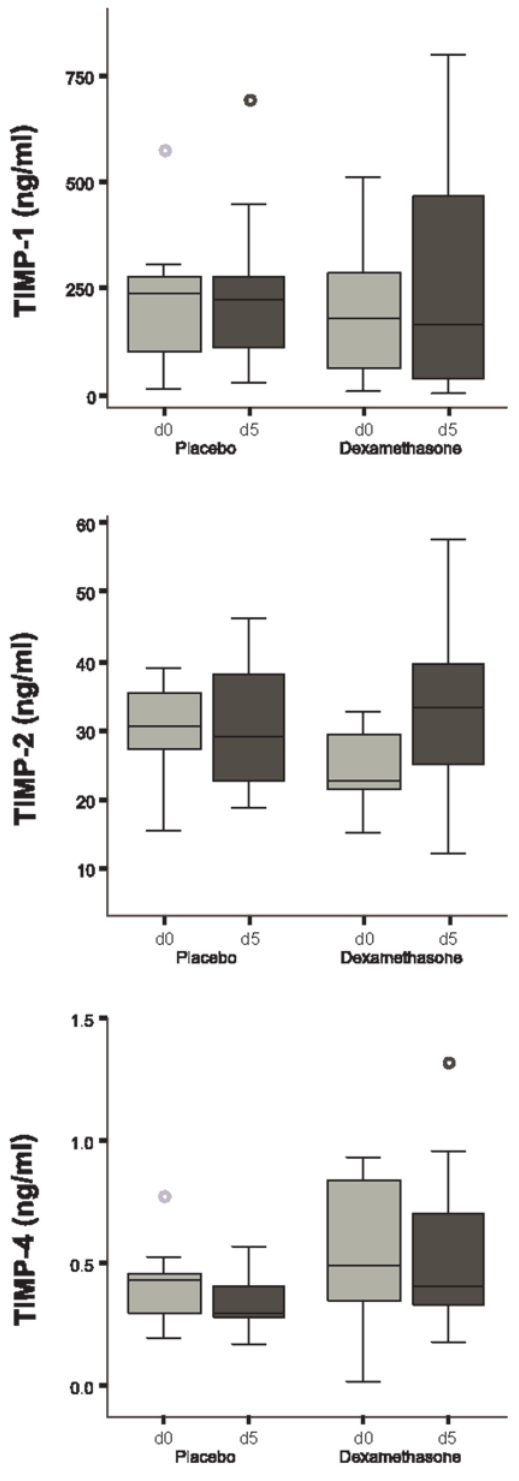
Figure 2. CSF TIMP concentrations in early follow up samples are not affected by dexamethasone. Paired CSF samples from patients with tuberculous meningitis were taken pre-treatment and at early follow up, a median 5 days (range 3–8) into anti-tuberculosis therapy, and analyzed for TIMP-1, -2, & -4 concentrations by ELISA. The black line represents the median value and the box the interquartile range. Whiskers represent 1.5 times the interquartile range away from the box. doi:10.1371/journal.pone.0007277.g002 PLoS ONE |